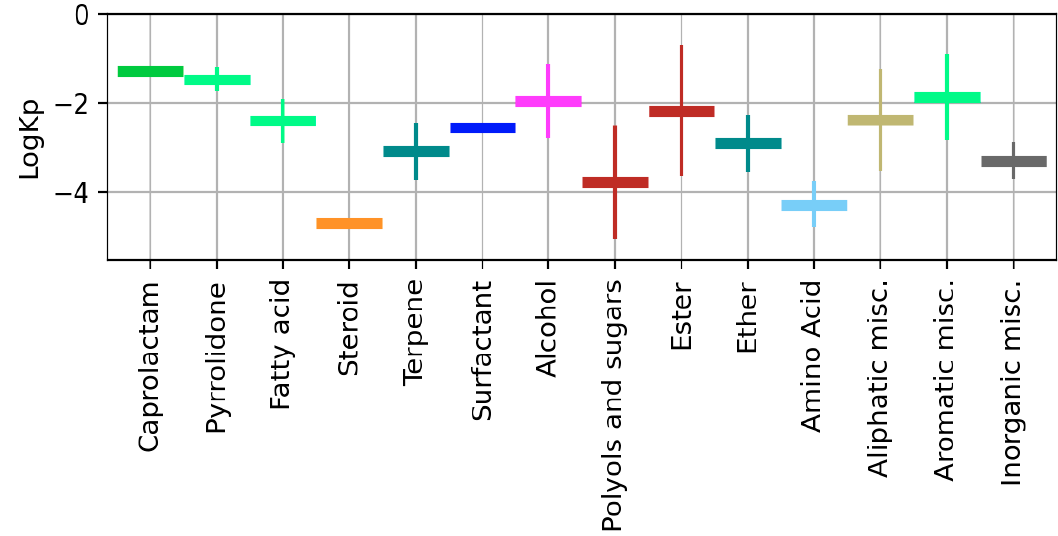
Figure 6. Mean value and S.D. of logKp calculated for different CPE classes.